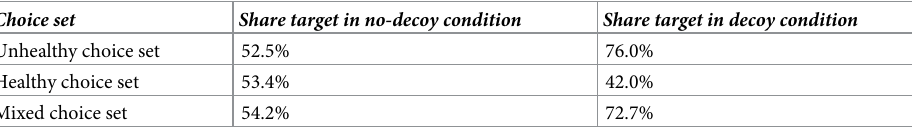
Table 2. Relative share of the target product per